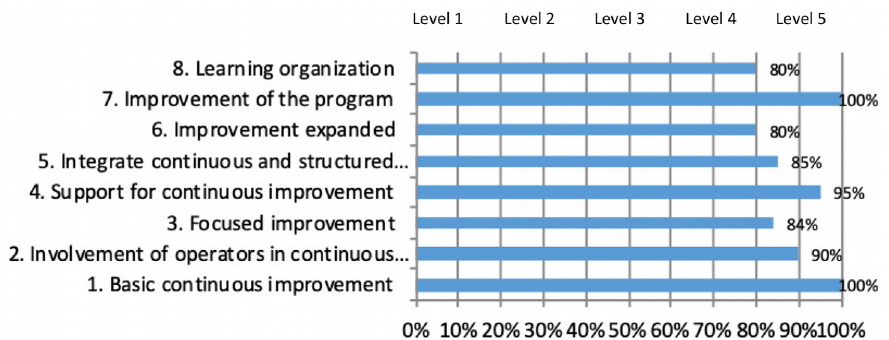
Figure 4. Maturity level in